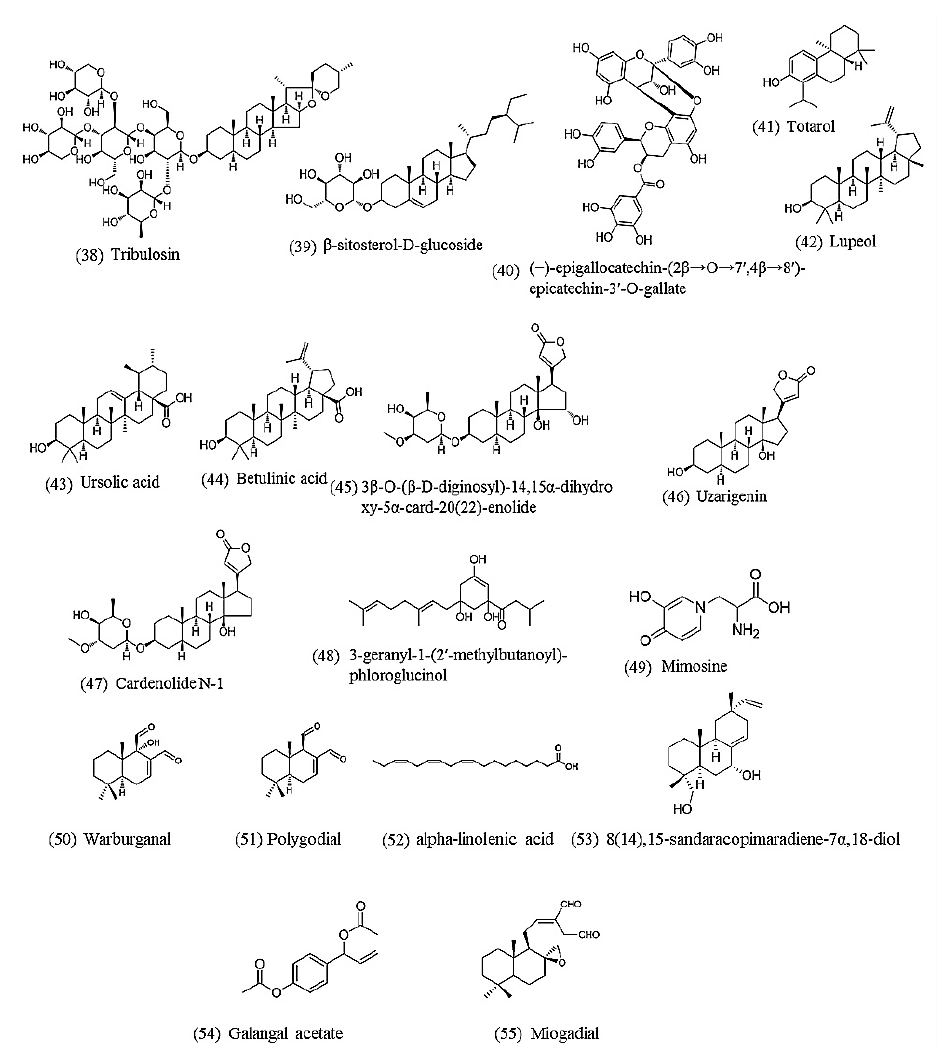
Figure 2. Chemical structures of natural products active against C. elegans . Lipids (52), phenolics (40), saponin (38,39), terpenoids (41,42,43,44,49,50,51,53), steroids (45,46,47), miscellaneous